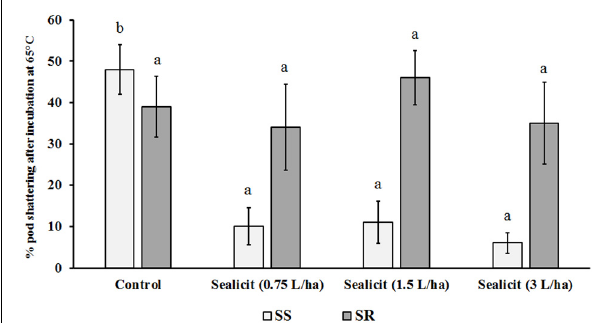
FIGURE 2 | Effects of Sealicit TM rate on soybean pod shattering. Each bar represents the percentage of open pods versus total number of pods. Different letters within the same soybean variety indicate statistically significant differences between the treatments based on one-way ANOVA Tukey’s HSD test at p ≤ 0.05. Number of biological replicates ( n =